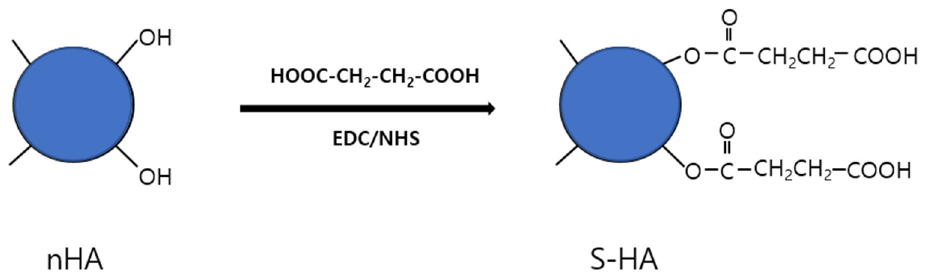
Figure 1. Schematic diagram showing the chemical bonding of succinic acid (S) to the surface of nHA particles.